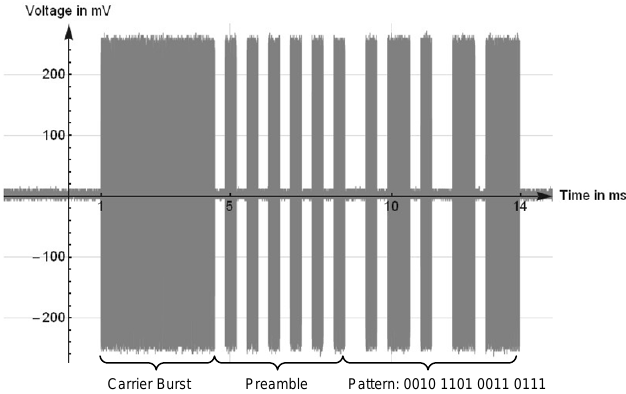
Figure 5. Flowchart of the gateway software.